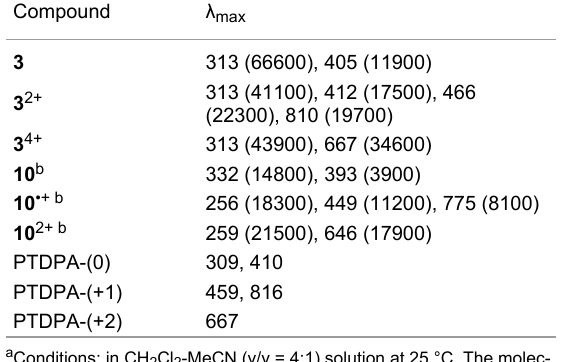
Table 2: Absorption maxima of 3 , 10 and PTDPA. a